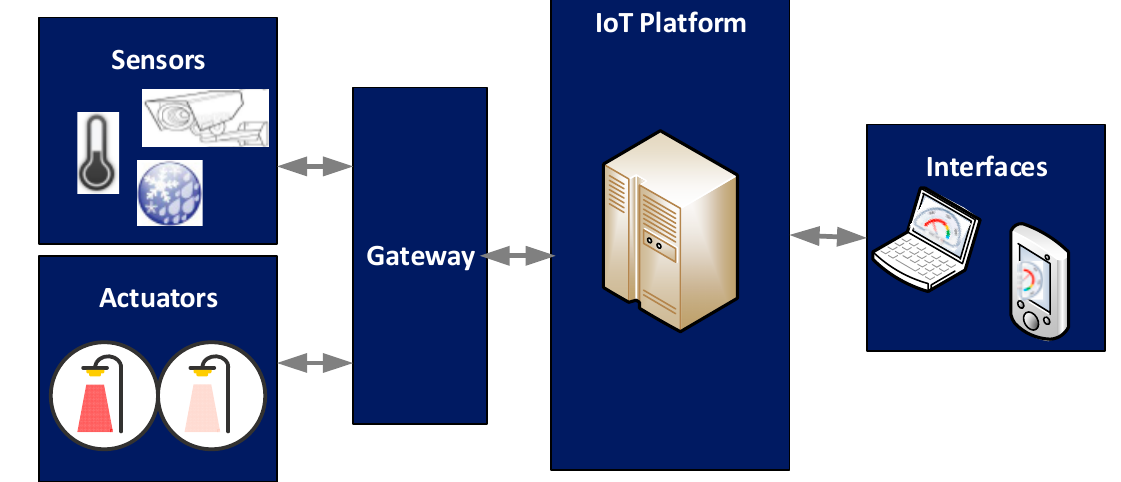
Figure 10. Dynamic street lighting system overview.